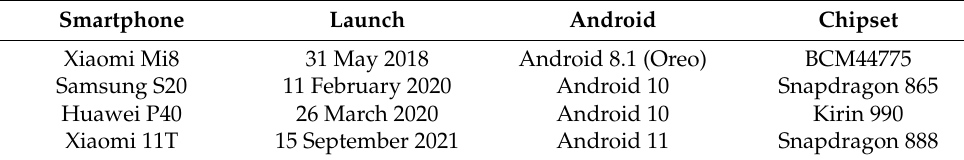
Figure 1. ( a ) Leica GS18 receiver and two smartphones setup; ( b ) jammers used in the experiment. Table 1. Some basic characteristics of smartphones used in the experiment.